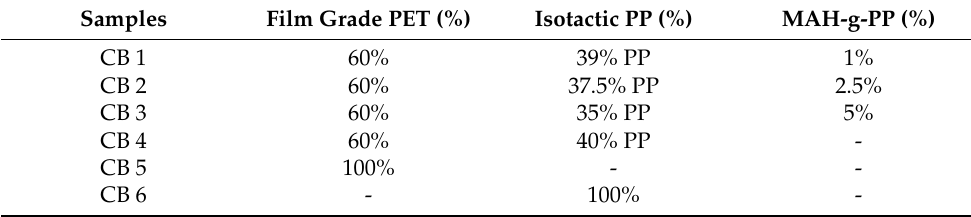
Table 2. Composition details of Polypropylene (PP) /Polyethylene terephthalate (PET) PP/PET